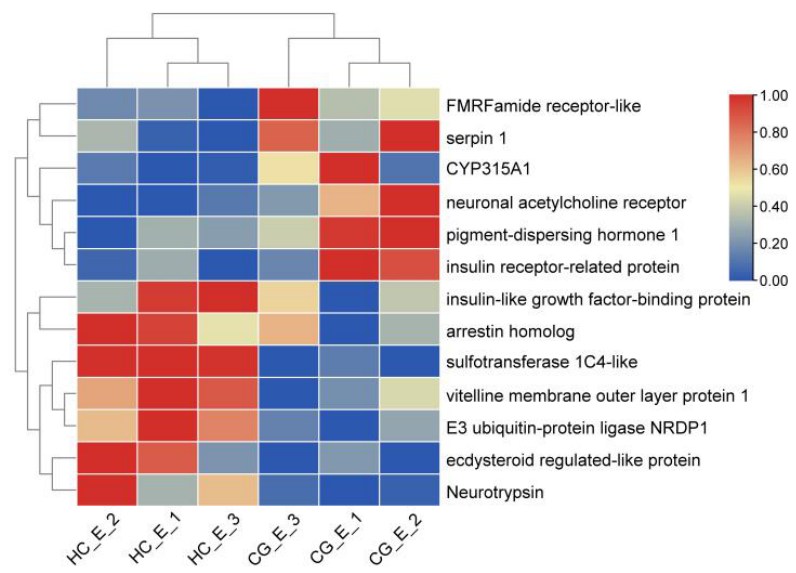
Figure 5. The heatmap of DEGs related to ovarian development in the HC_O vs. CG_O group. The columns and rows indicate individuals and genes, respectively. The color scale represents FPKM after standard normalization, the same as below.